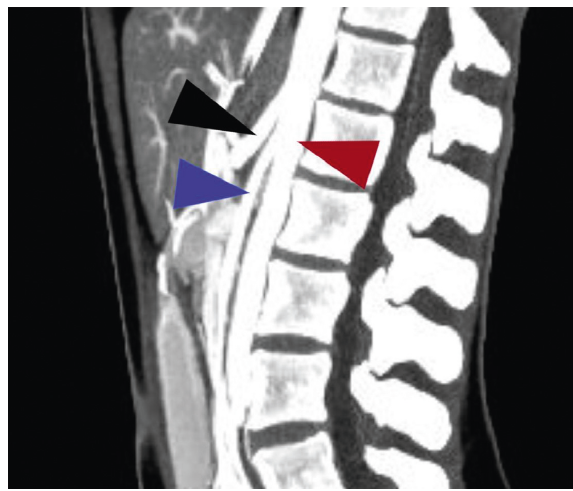
Figure 2: CT angiography revealing severe acute angularity of the SMA-aortic take off. Black arrow: celiac artery; maroon arrow: aorta; blue arrow: superior mesenteric